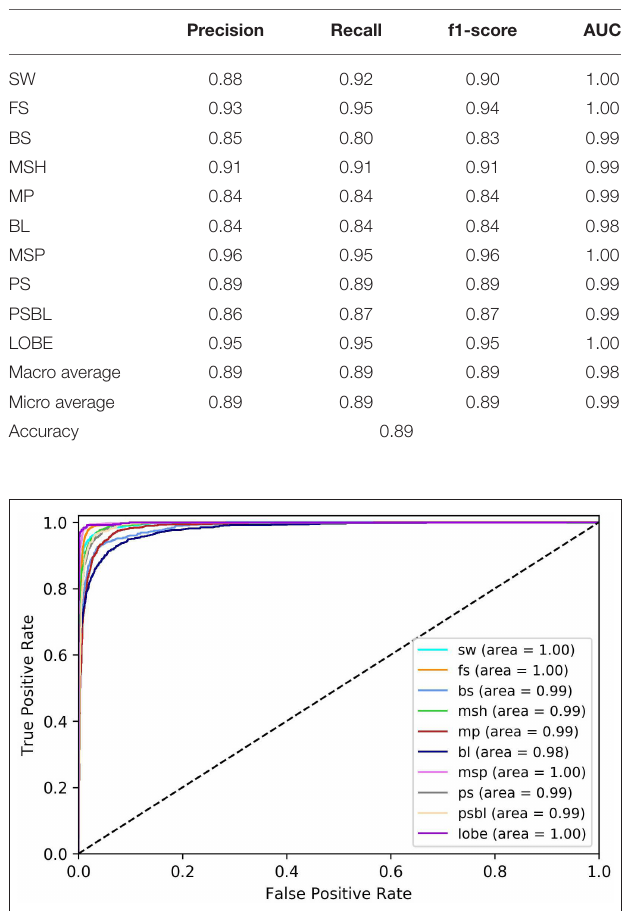
TABLE 3 | Classification report for FCN computed on the test set.